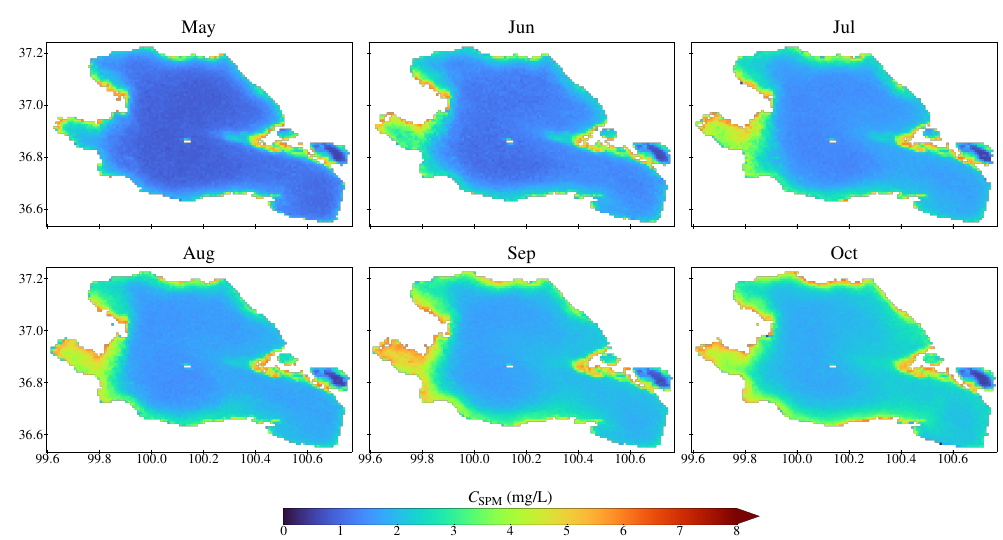
Figure 8. Monthly mean spatial distribution of the C SPM in Qinghai